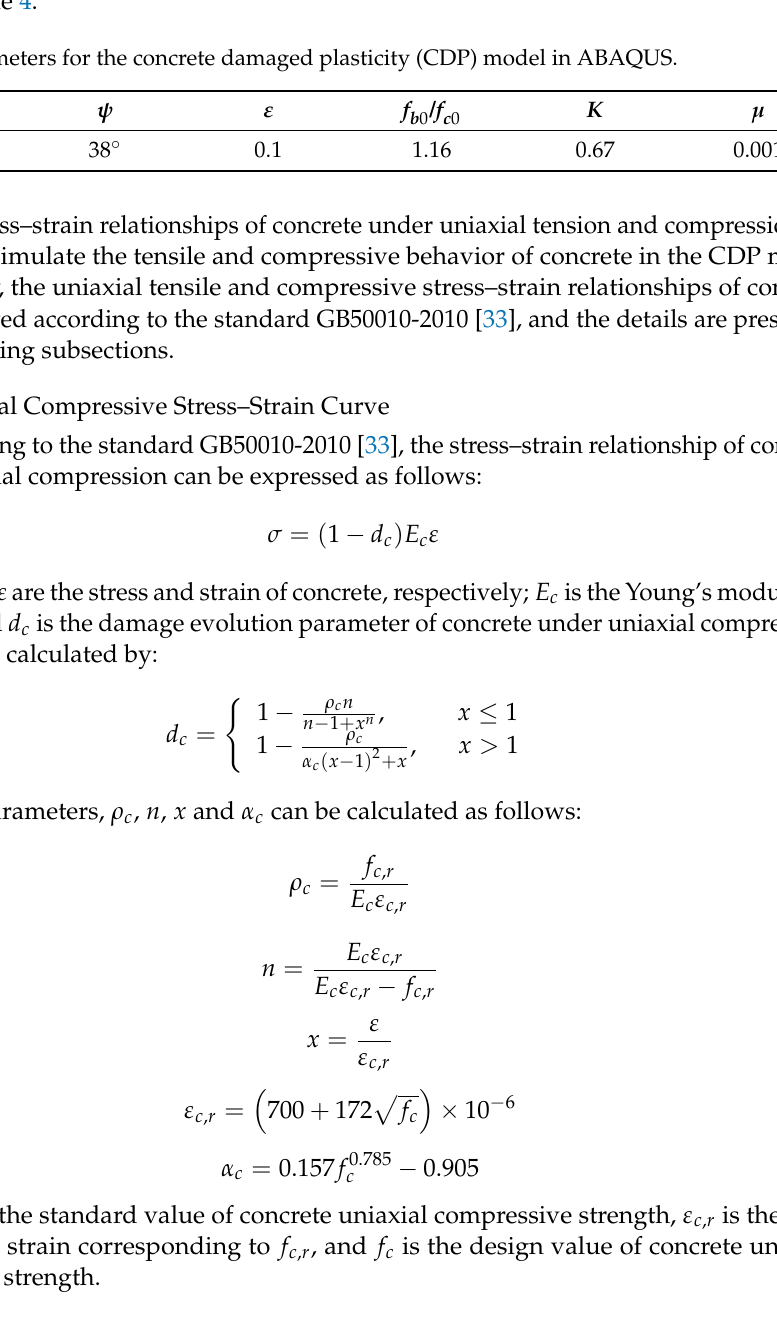
Table 4. Parameters for the concrete damaged plasticity (CDP) model in ABAQUS. Parameter ψ ε f Value 38 ◦ 0.1 1.16 0.67